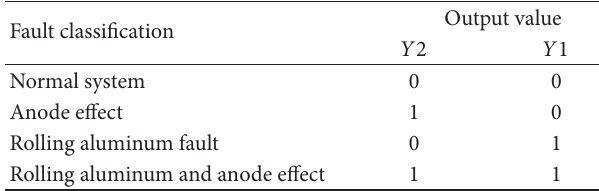
Table 1: The network fault model and the corresponding output